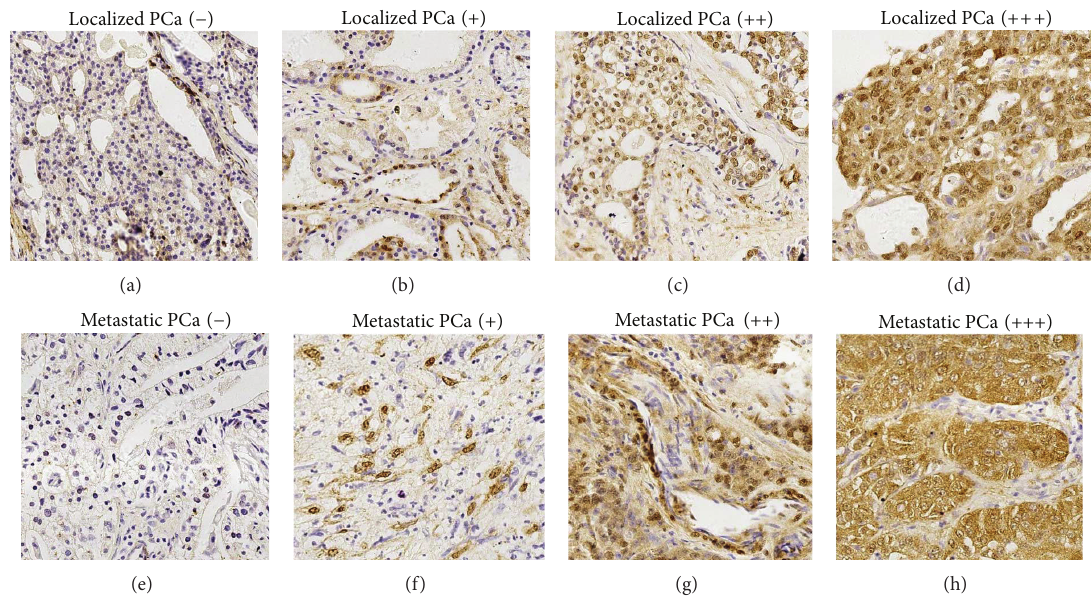
Figure1:ImmunohistochemicallystainedlocalizedandmetastaticPCatissuesfrompatients.(a)localizedPCatissueswithoutG 𝛼 sexpression ( − ); (b) localized PCa tissues with weak G 𝛼 s expression (+); (c) localized PCa tissues with moderate G 𝛼 s expression (++); (d) localized PCa tissues with strong G 𝛼 s expression (+++); (e) metastatic PCa tissues without G 𝛼 s expression ( − ); (f) metastatic PCa tissues with weak G 𝛼 s expression (+); (g) metastatic PCa tissues with moderate G 𝛼 s expression (++); (h) metastatic PCa tissues with strong G 𝛼 s expression (+++). Representative images were taken under a microscope ( ×